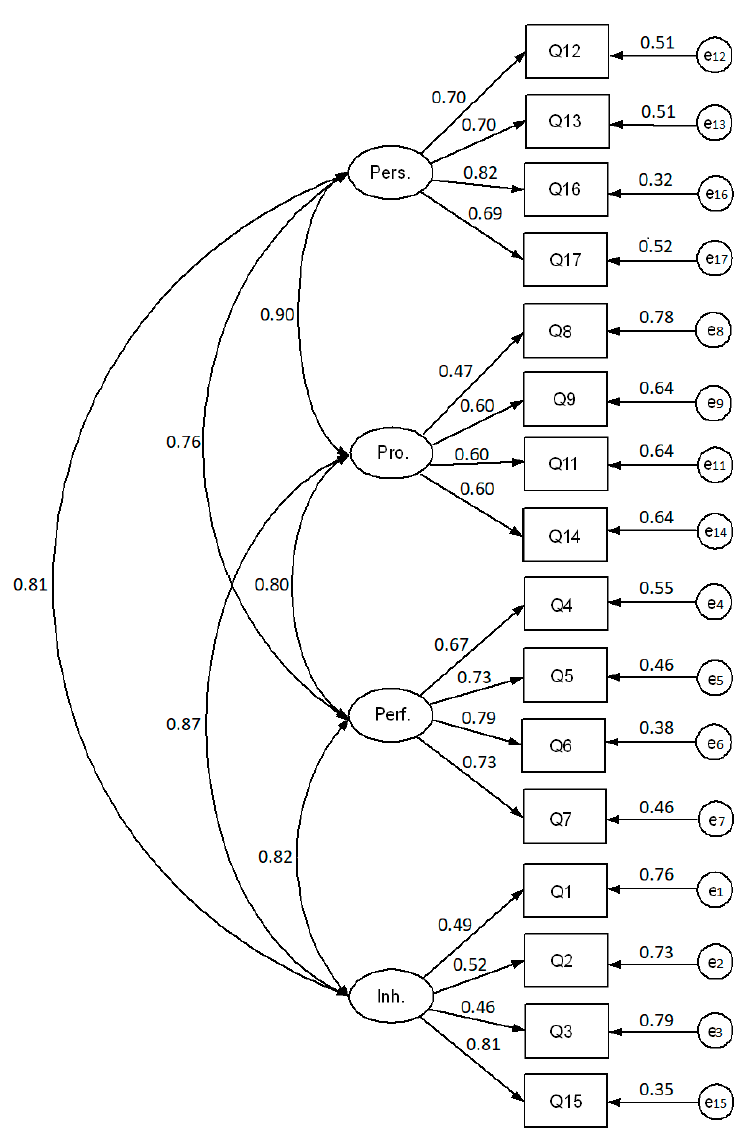
Figure 1. Confirmatory factor analysis estimates of the 16-item questionnaire in Polish to measure the career satisfaction of physicians. The dimensions of career satisfaction are personal (pers.), professional (pro.), performance (perf.), and inherent (inh.). This analysis was completed with the original 16 items of the 4CornerSAT in Polish.